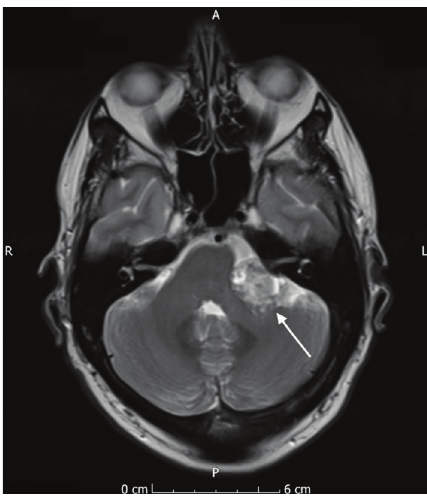
Figure 2: Axial MR image (T2 weighted, fat saturated) showing the vestibular schwannoma affecting the left vestibulocochlear